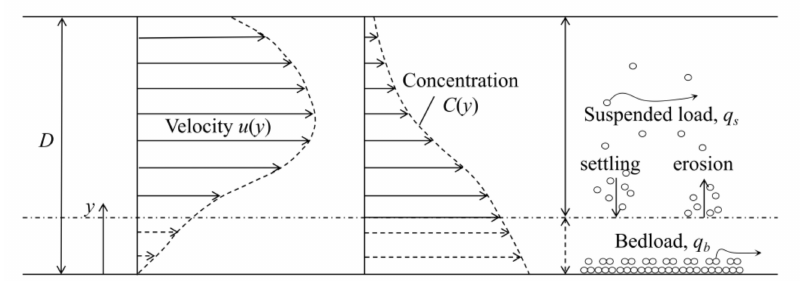
Figure 11. Sketch of the velocity distribution, concentration profile, as well as the sediment settling and erosion processes (modified from Julien, 2010